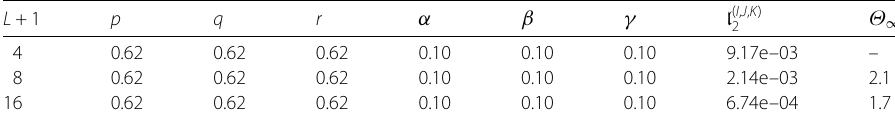
Table 3c Errors and computational rate for the EF-EEG-TOCS in Example 5.3 L + 1 p q r α β γ l ( I , J , K ) 2 Θ ∞ 4